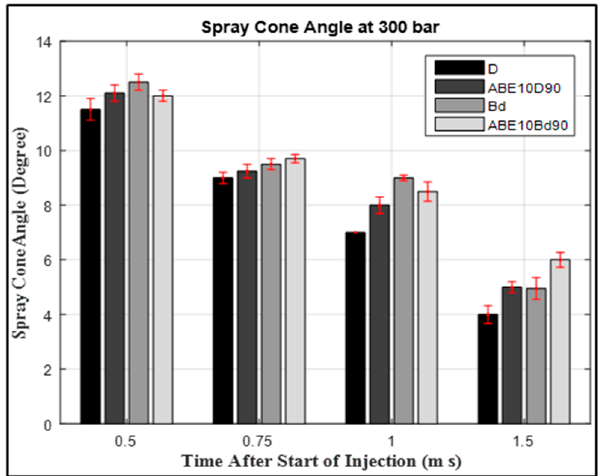
Figure 6. Spray cone angle of test blends.